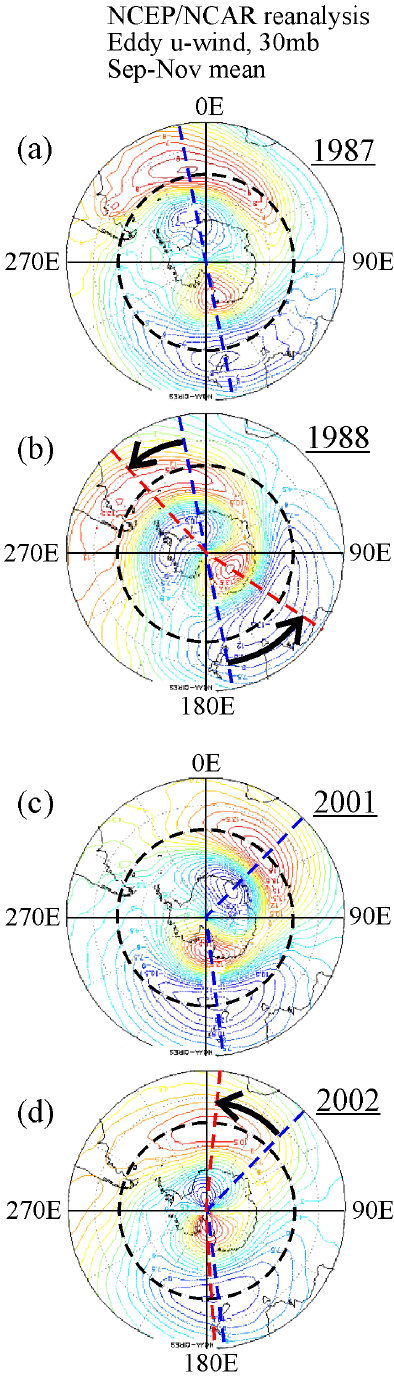
Fig. 3. Position of the zonal anomalies (dashed radial lines) of the September–November mean zonal wind under conditions of the strong (a, c) and weak (b, d) stratospheric polar vortex. NCEP/NCAR reanalysis data for the pressure level of 30hPa to the south of 30 ◦